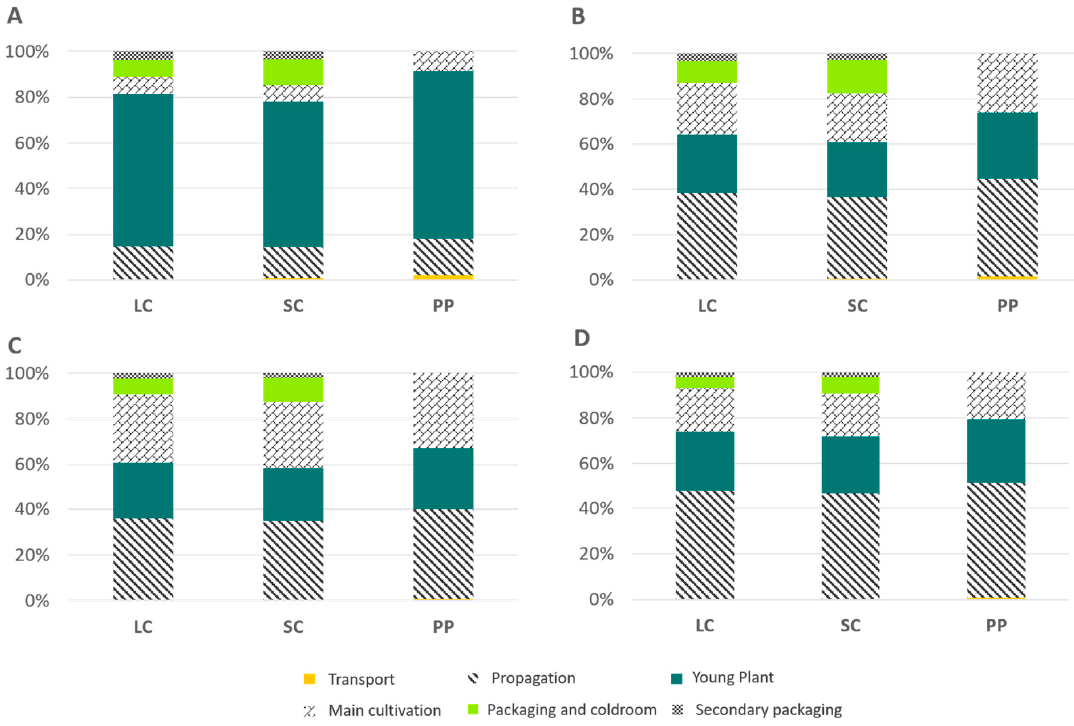
Figure 4. Viola cornuta relative contribution (%) to the impact categories of each life cycle stage. Transportation stage is scarcely visible at this scale since it accounts for a small part of the total contribution. Each column shows the production burdens related to a specific type of final product: LC = Large Container. SC = Small Container. PP = Potted Plant. A: Global Warming Potential (GWP). B: Acidification Potential (AP). C: Eutrophication Potential (EP). D: Photochemical Ozone Creation Potential (POCP).